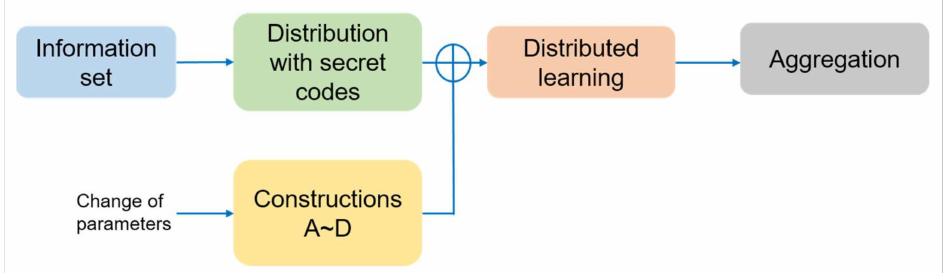
Figure 3. A framework for distributed systems with secret